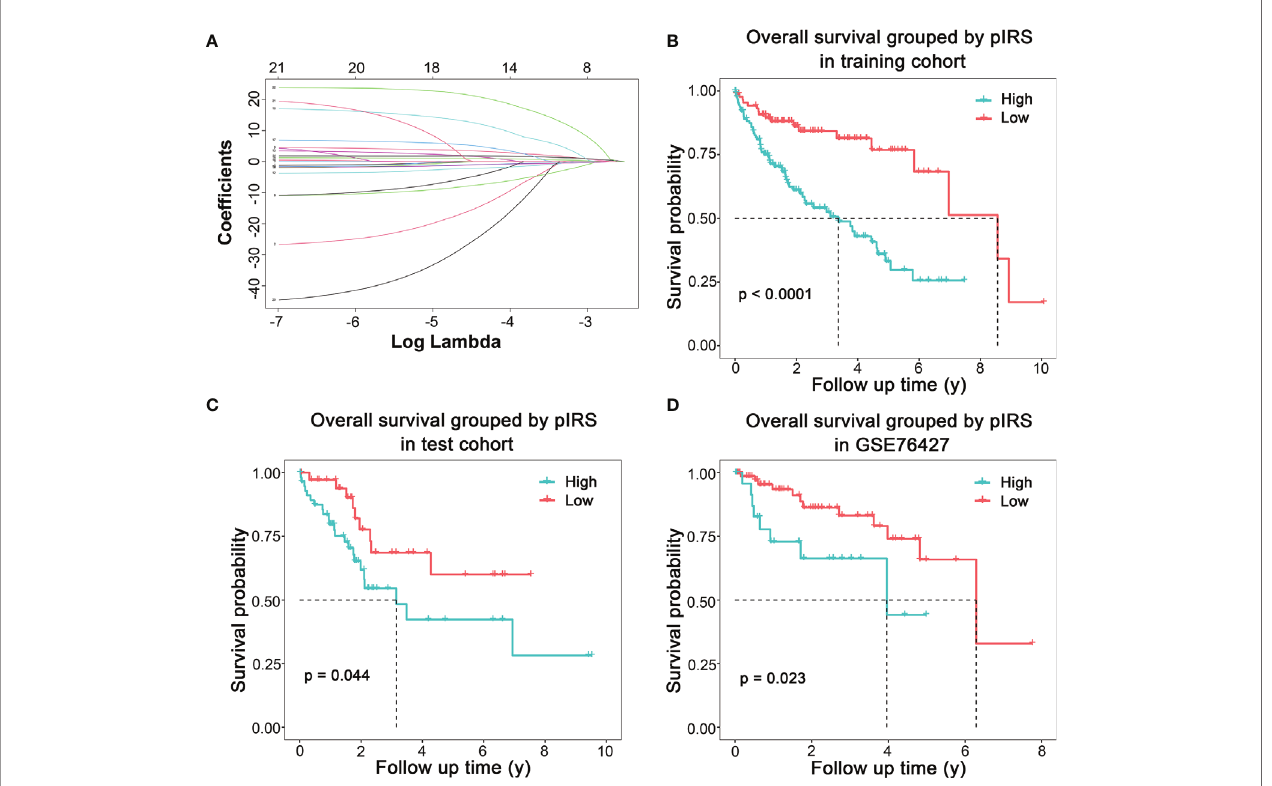
FIGURE 3 | Prognostic model of HCC based on immune cells in fi ltration. (A) Coef fi cients of different numbers of variables in LASSO regression model. (B) Modeling based on TCGA training cohort. (C) Internal test based on TCGA test cohort. (D) External validation based on